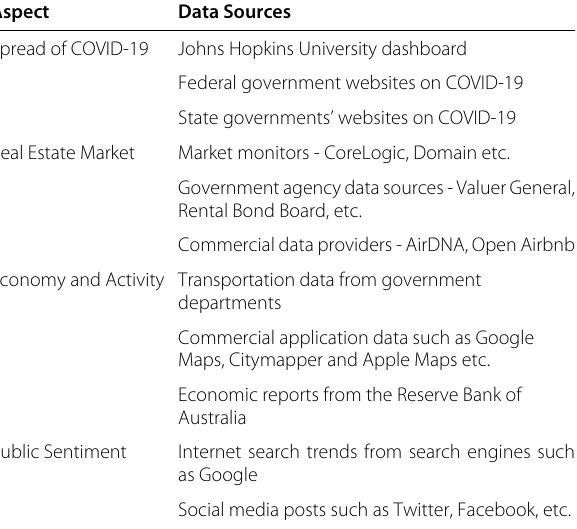
Table 1 Data sources considered for understanding aspects